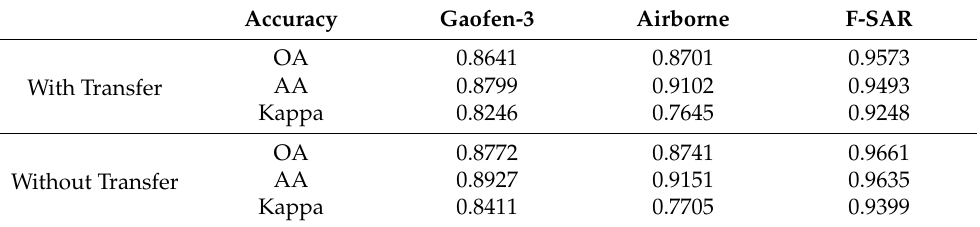
Figure 15. Classification maps of F-SAR image with different methods. ( a ) Ground-truth. ( b ) Gabor. ( c ) CoTF. ( d ) BOVW. ( e ) DCAE. ( f ) EPLS. ( g ) SCNN. ( h ) A-ConvNet. ( i ) MFFN-GAP. ( j ) MSCP. ( k ) MFFN-CPMN. Table 9. Comparison of the performance with or without transfer model from the TerraSAR-X image.